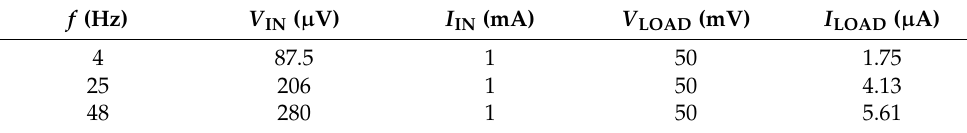
Figure 17. Simulated magnitude ( a ) and phase ( b ) characteristics of gyrator input admittance implementing FO inductor for the respiratory model. Table 5. Maximum allowed voltages and currents in the gyrator